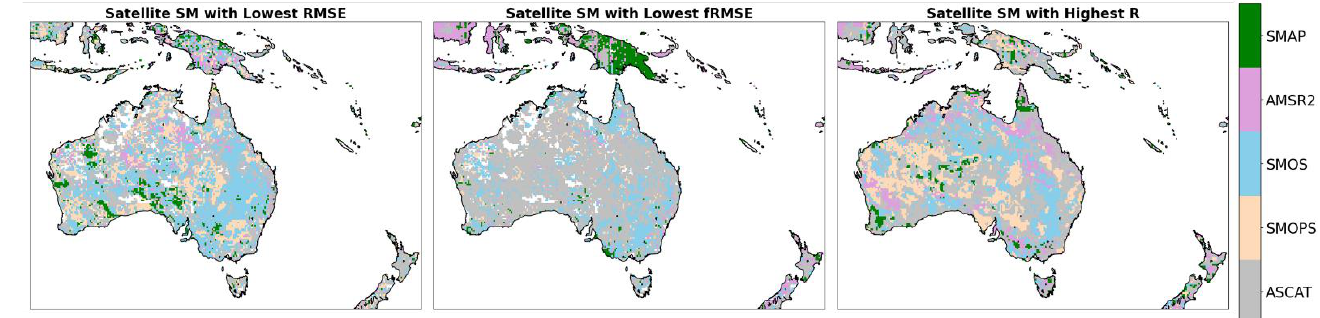
Figure 13. ASCAT, SMOPS, SMOS, AMSR-2, and SMAP spatially ranked by best performance for RMSE, fRMSE, and R for each grid cell in the study domain.